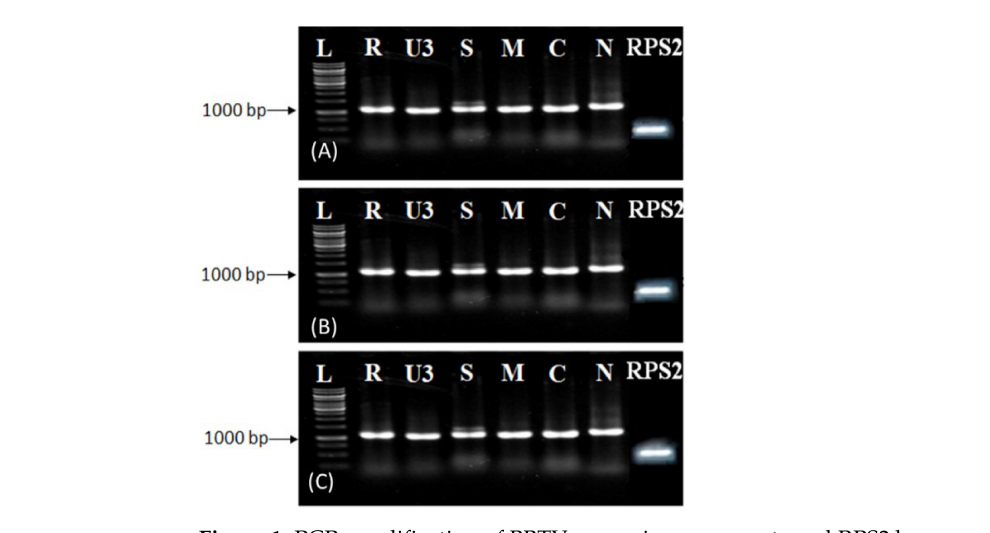
Figure 1. PCR amplification of BBTV genomic components and RPS2 banana gene. L = GeneRuler 1 kb DNA ladder (Thermo Scientific, Vilnius, Lithuania), PCR amplified fragment of DNA-R, -U3, -S, -M, -C, -N, and RPS2 banana gene from Leaf ( A ), Midrib ( B ), and Root tissues ( C ).